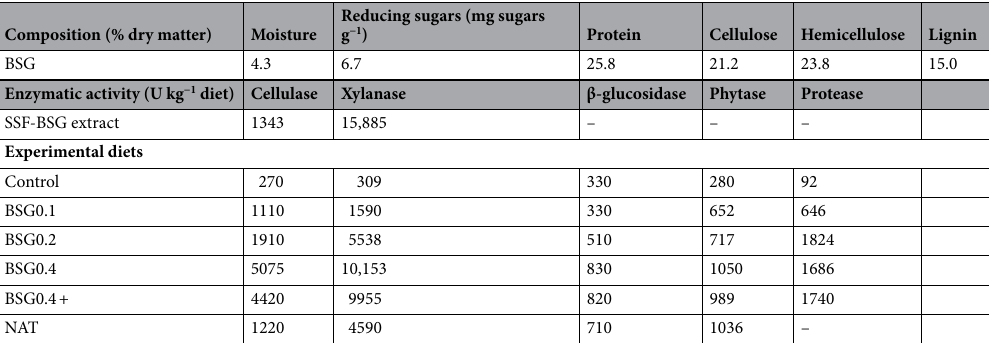
Table 1. Brewer’s spent grain composition and enzymatic activities of SSF-BSG extract and experimental diets. BSG: Brewer’s spent grain. SSF-BSG extract: lyophilized extract obtained after solid-state fermentation of BSG with Aspergillus